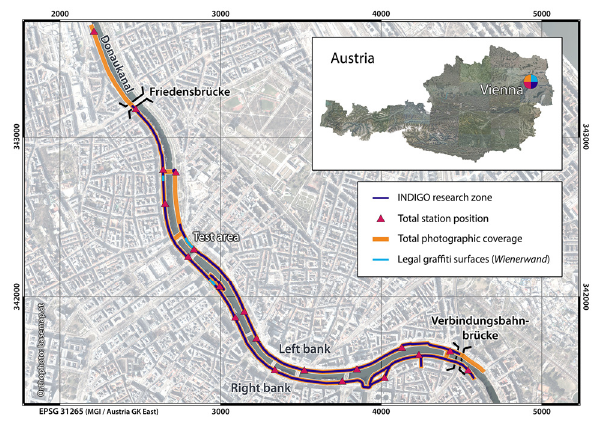
Figure 2 . The INDIGO research zone in the centre of